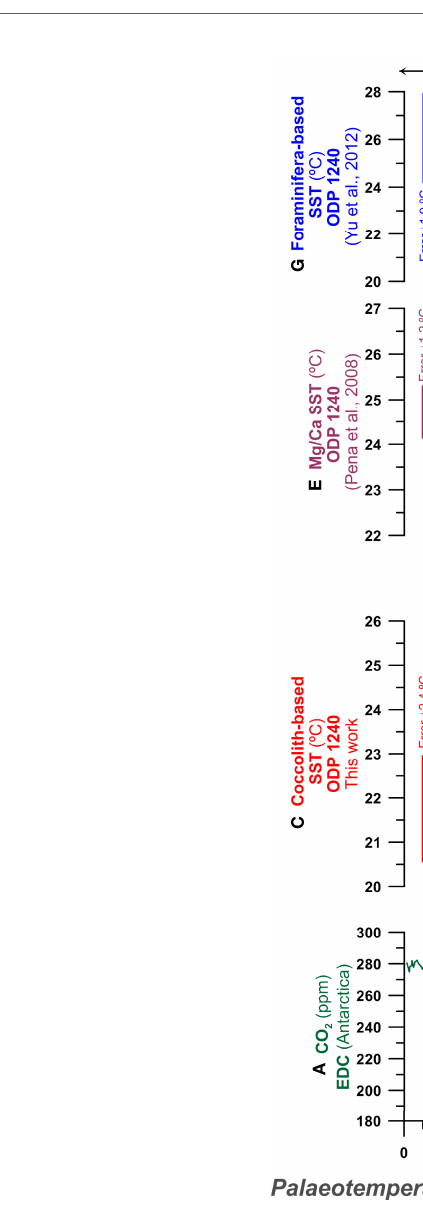
FIGURE 9 | Palaeotemperature records for the last 20 kyr in eastern equatorial Paci fi c Ocean. (A) CO 2 (ppm) EDC (Luthi et al., 2008); (B) d 18 O ( ‰ ) record from the planktonic foraminifera Globorotaloides hexagonus at ODP Site 1240 (Max et al., 2017; Rippert et al., 2017); (C) coccolith-derived sea surface temperature SSTa, (°C) at ODP Site 1240 (this work) with 5-point running average smoothing; (D) SSTs (°C) based on Mg/Ca from Globigerinoides ruber in the core TR-163-22 (Lea et al., 2006); (E) SSTs (°C) based on Mg/Ca in G. ruber at ODP Site 1240 (Pena et al., 2008); (F) alkenone-derived sea SSTs (°C) from core ME0005A-24JC (Kienast et al., 2006); (G) Foraminifera-derived SSTs (°C) at ODP Site 1240 (Yu et al., 2012). Shaded areas indicate the Heinrich 1 (H1), Older Dryas, Bølling – Allerød (BA) and Younger Dryas (YD). Vertical bars indicate the error estimated for the different SST proxies; Müller et al. (1998) was used for alkenones and Dekens et al. (2002) for